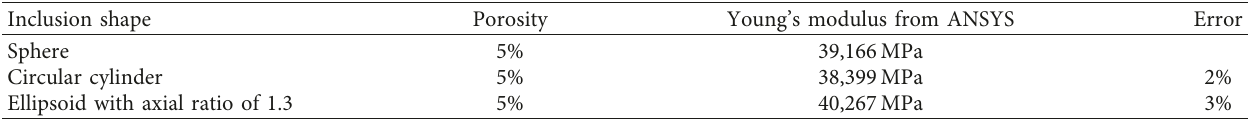
Table 3: Summarization of back-calculated Young’s modulus and associated errors for different inclusion shapes. Inclusion shape